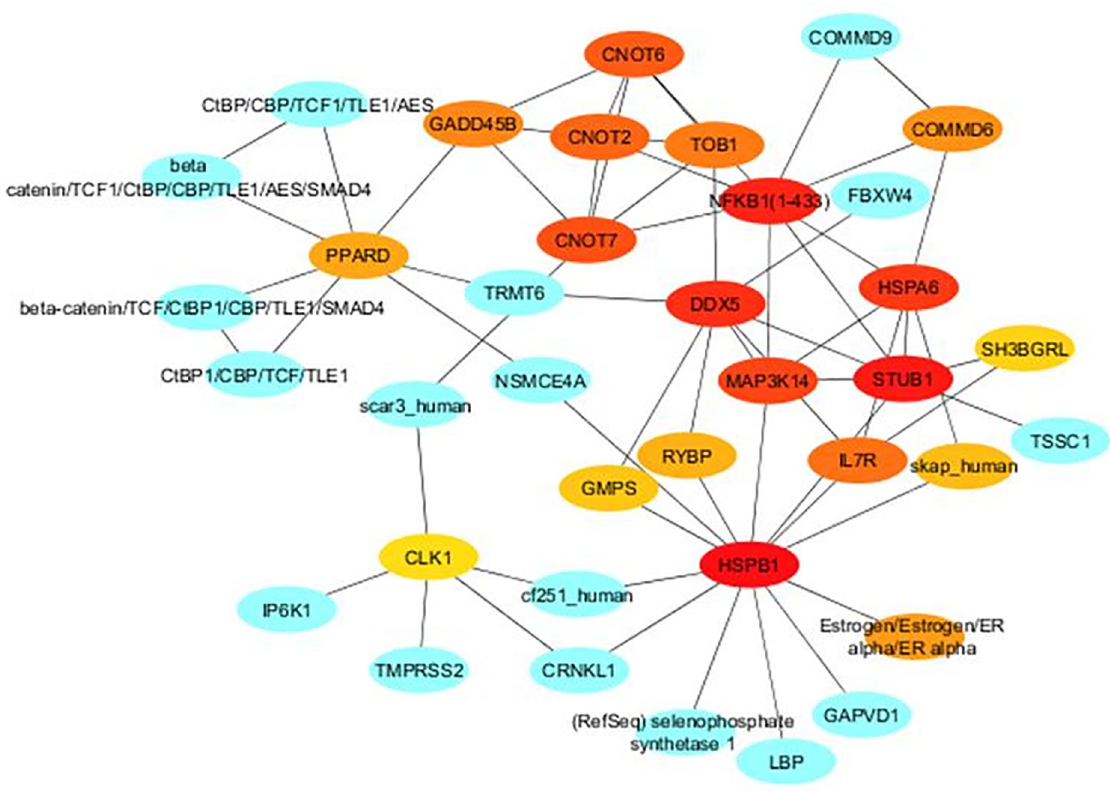
Fig 4. Subnetwork of core DE genes with � 5.0 degree and a fold change of � 2.0 (50 nodes and 97 edges). Colour intensity of top 20 genes decreases with increasing order of rank (from light orange to red).